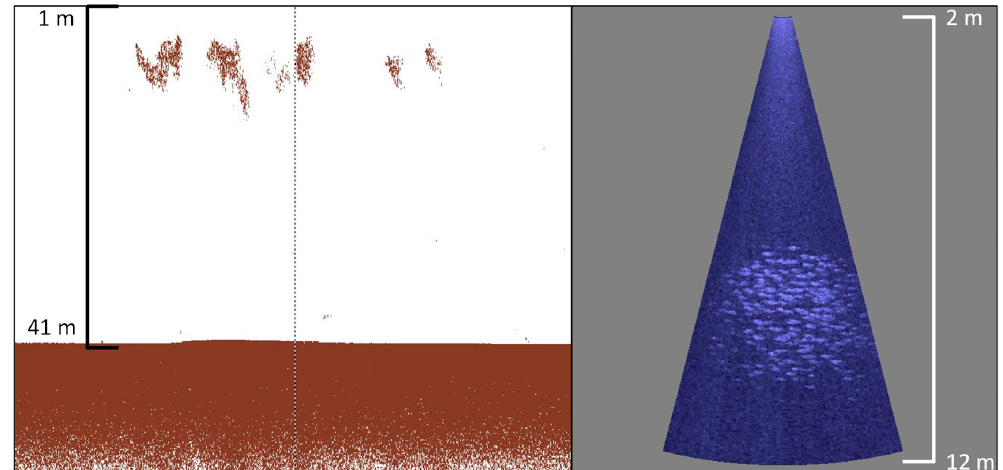
Figure 3. Simultaneous views of a fish school collected with the Simrad single beam echosounder and − 30 dB re 1 m 2 threshold applied. A DIDSON data frame is on right, has no threshold applied, and corresponds in time to vertical dashed line in the Simrad echogram. Time on the Simrad single beam echosounder is from left to right. Time on the DIDSON is frame by frame like a video. See supplementary file for video.